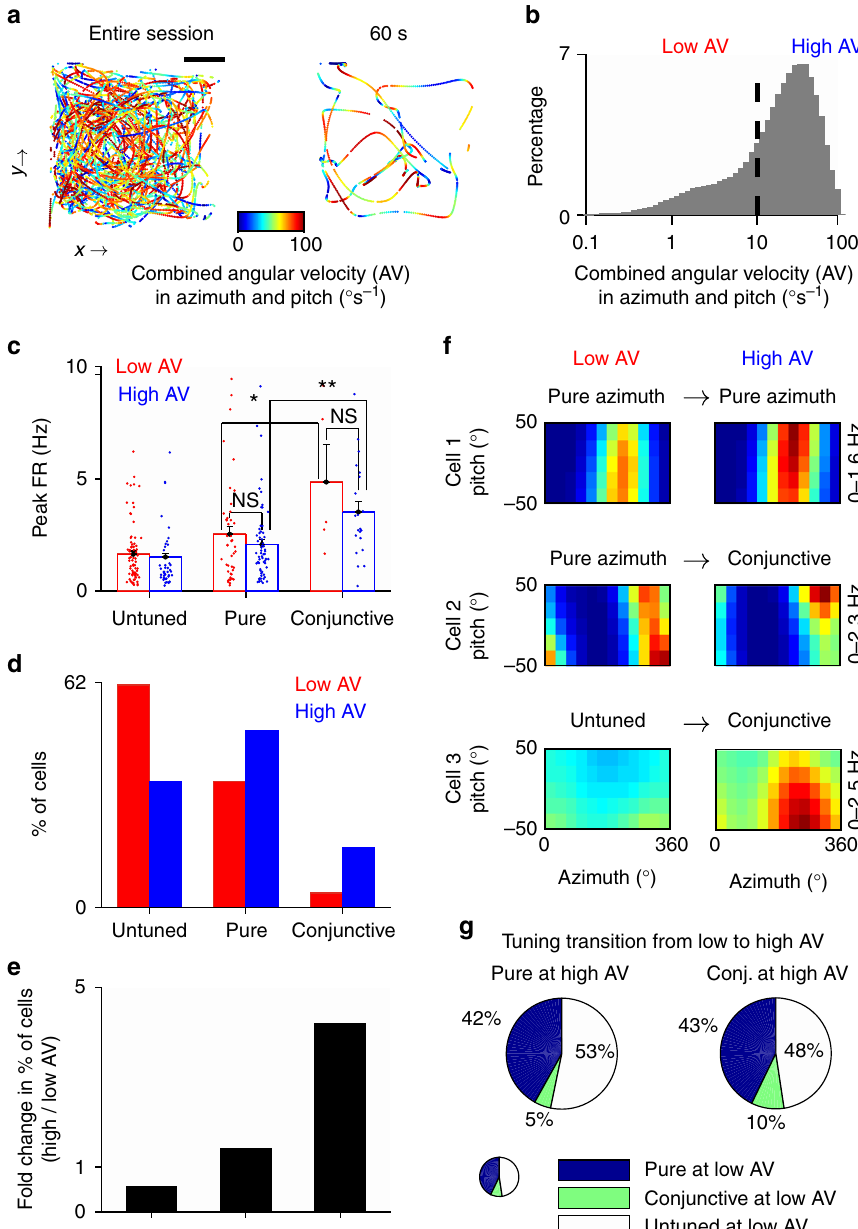
Fig. 6 Dynamic shifts from pure to conjunctive tuning in head-direction cells as a function of angular velocity. a Top view of the trajectory of a bat crawling on the fl oor of a horizontal arena, color-coded according to combined (azimuth × pitch) angular velocity (AV). Left, trajectory from an entire session; scale bar, 10 cm. Right, 60 s trajectory from the same session. During crawling, there were frequent transitions between epochs of low and high angular velocity. b Distribution of the combined (azimuth × pitch) angular velocity in crawling bats. A cutoff of 10 degrees per second (dashed line) was used to separate between low and high angular velocity. c Peak- fi ring rates of untuned, pure, and conjunctive cells during low or high angular velocity. There was no signi fi cant difference in the peak- fi ring rate computed at different angular velocities. For both low and high angular velocity, conjunctive cells had higher peak- fi ring rate than pure cells. Error bars, mean ± s.e.m.; * P < 0.05, ** P < 0.01, using Student ’ s t -test. d Fractions of untuned cells and cells with pure or conjunctive tuning to azimuth and pitch, plotted separately for low (red) versus high angular velocity (blue). e Ratio between the percentages of cells in high/low angular velocity, plotted separately for each of the 3 cell classes (3 bars). The percentage of conjunctive cells increased fourfold in high versus low angular velocities. f Examples of 3 neurons recorded in the dorsal presubiculum of crawling bats with different tuning properties. Shown are 2D rate- maps as a function of azimuth and pitch, computed separately for low (left) and high angular velocity (right). The signi fi cant dimensions to which each cell was tuned, under low or high angular velocities, is indicated above the map. Color scale: zero (blue) to maximal fi ring rate (red), values in Hz are indicated. g Proportions of tuning-type transitions between low and high angular velocities, for cells with pure (left) or conjunctive tuning (right). For example, the right pie chart shows — for cells with conjunctive tuning at high angular velocity — what percentage of these cells had pure, conjunctive, or no tuning at low angular